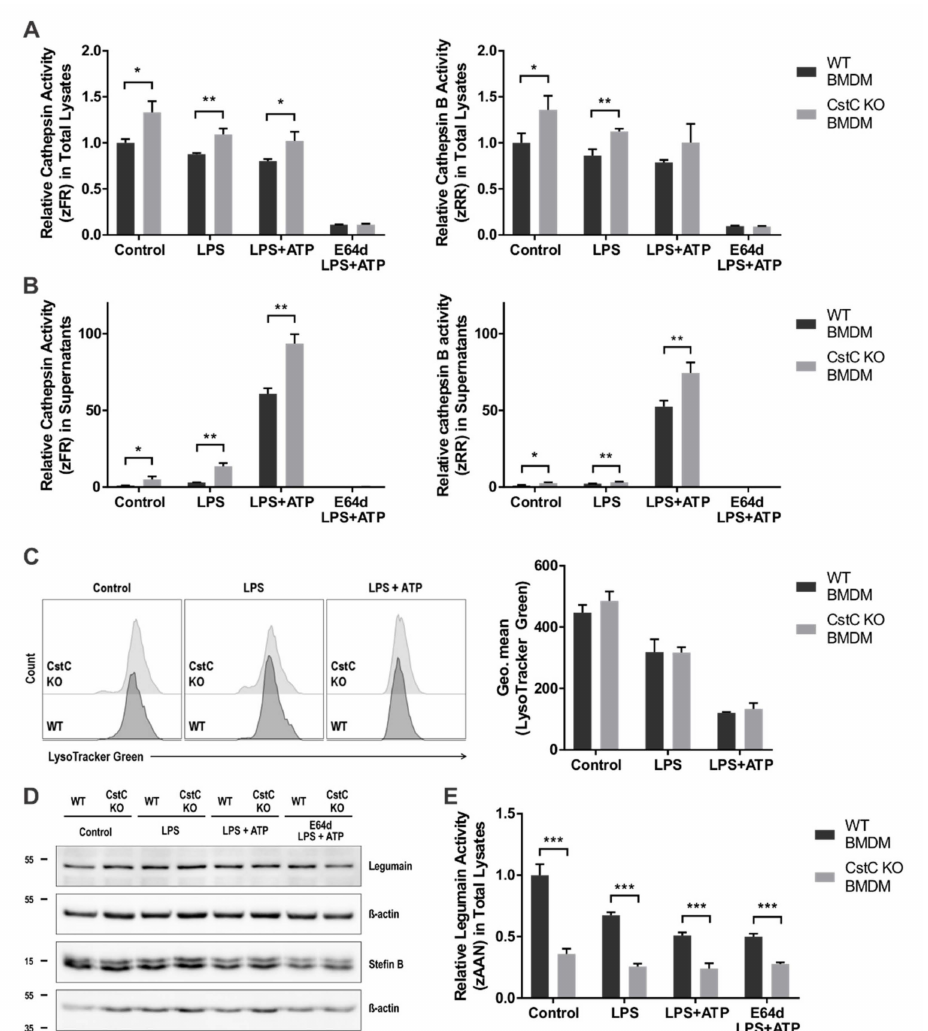
Figure 2. Increased cysteine cathepsin and decreased legumain activity in CstC KO BMDMs. BMDMs were pre-treated for 2 h with E-64d (20 µ M), primed for 4 h with LPS (100 ng/mL) and stimulated for 20 min with ATP (5 mM) as indicated. ( A ) BMDMs were lysed with digitonin (200 µ g/mL) and cysteine cathepsin activity was measured using fluorogenic substrates specific for cathepsins (zFR—cathepsin L-like activity; zRR—cathepsin B-like activity). ( B ) Supernatants were collected and cysteine cathepsin activity was measured using fluorogenic substrates specific for cathepsins. ( C ) Lysosomal integrity was analyzed in cells labelled with LysoTracker Green. ( D ) Cell lysates were immunoblotted with indicated antibodies. Data shown are cropped blot images, representative of three independent experiments. ( E ) BMDMs were lysed with digitonin (200 µ g/mL) and legumain activity was measured using fluorogenic substrates specific for legumain (z-AAN). Data were ob- tained from three independent experiments performed in duplicate (panel C ) or triplicate, and the results are presented as means ± S.D. * p < 0.05; ** p < 0.01; *** p <